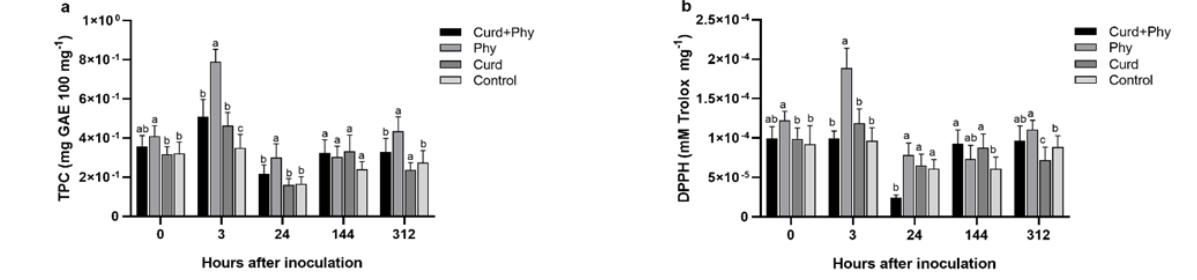
Figure 3. Effect of curdlan treatment on ( a ) TPC and ( b ) DPPH activity from avocado plant leaves inoculated with P. cinnamomi . Curd+ Phy, Phy, Curd and Control represent application of Curd one day before inoculation of P. cinnamomi , inoculation of P. cinnamomi , application of Curd without inoculation of P. cinnamomi and the control (distilled water), respectively. Data are presented as the mean ± standard deviation for nine replicates. Means with the same letter are not significantly different (ANOVA followed by Tukey’s test at p < 0.05).